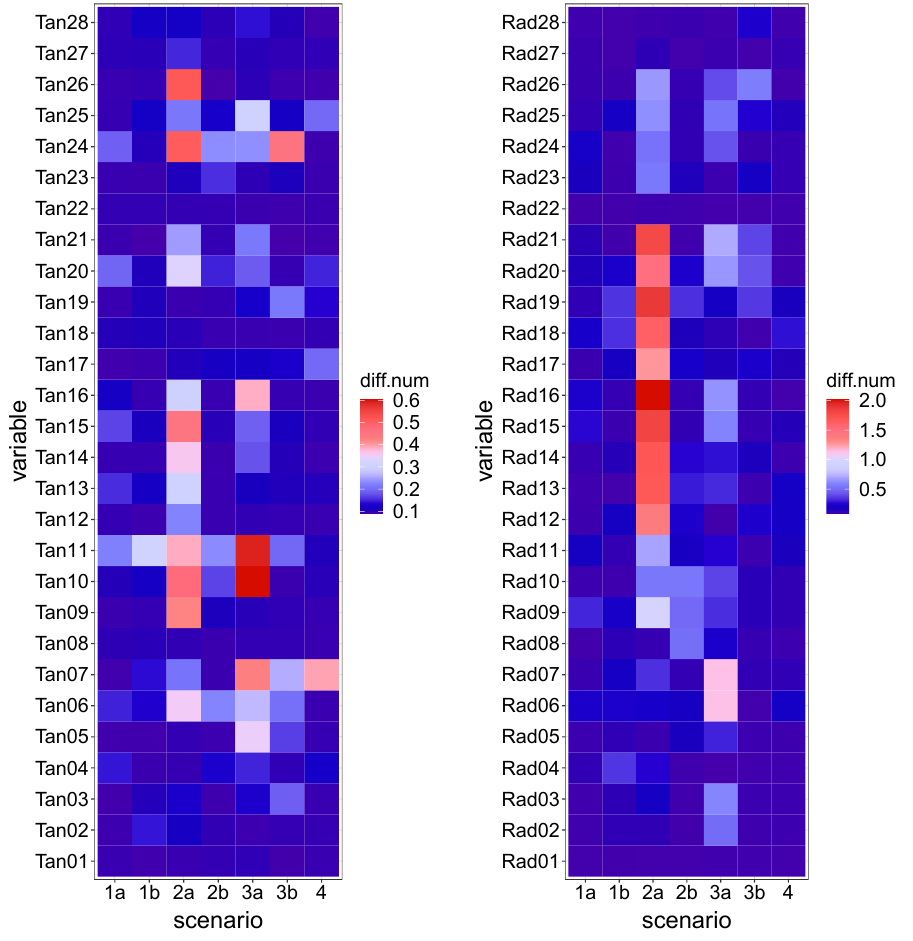
Figure 6. Median difference between anomaly scenarios and Scenario 0 for all tangential ( left ) and radial ( right ) displacements considered. Colour scales differ as corresponds to the typical higher variation of radial